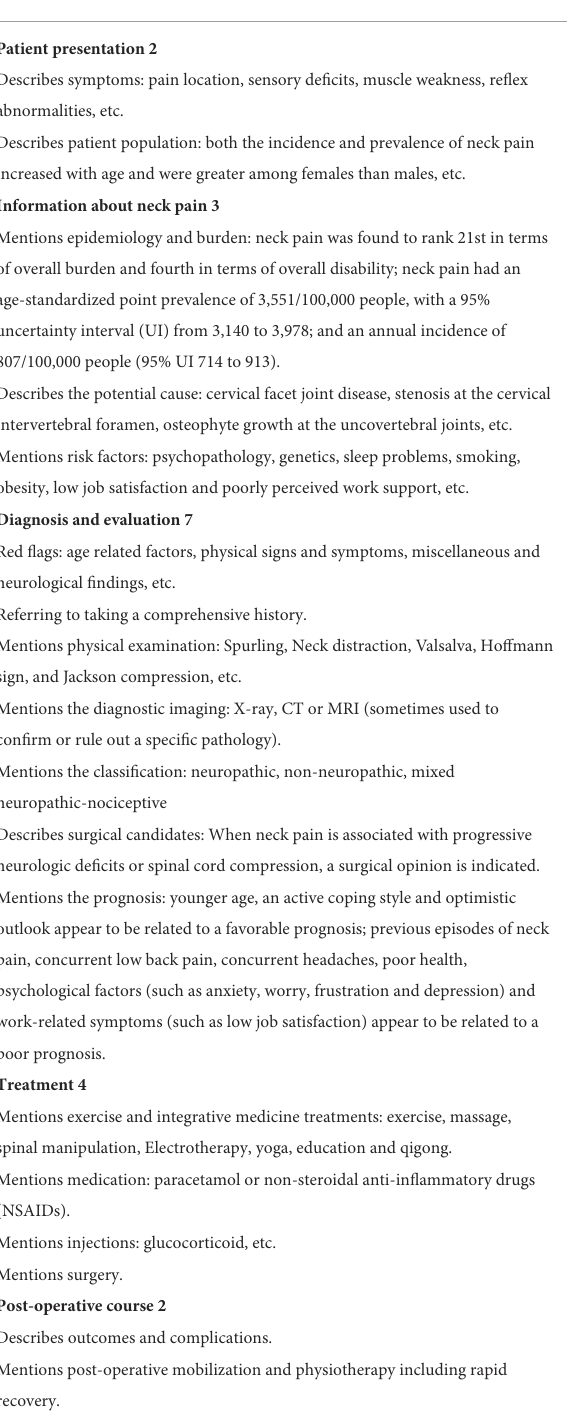
TABLE 4 The neck pain-specific